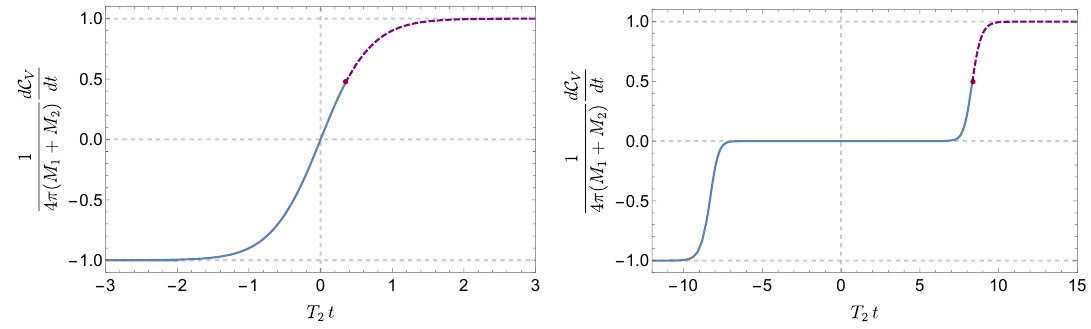
Figure 16. Time derivative of the complexity evolved with symmetric boundary times t t= 2 as a function of T 2 t normalized by the sum of masses for light shocks with w = 1 + 10 (cid:0) 5 for BTZ black holes (i.e., d = 2) for T 2 t w = 2 (left) and T 2 t w = 6 (right). The horizontal dashed lines indicate the limits (4.22) and (4.25) which are very close to those of the con(cid:12)guration without the